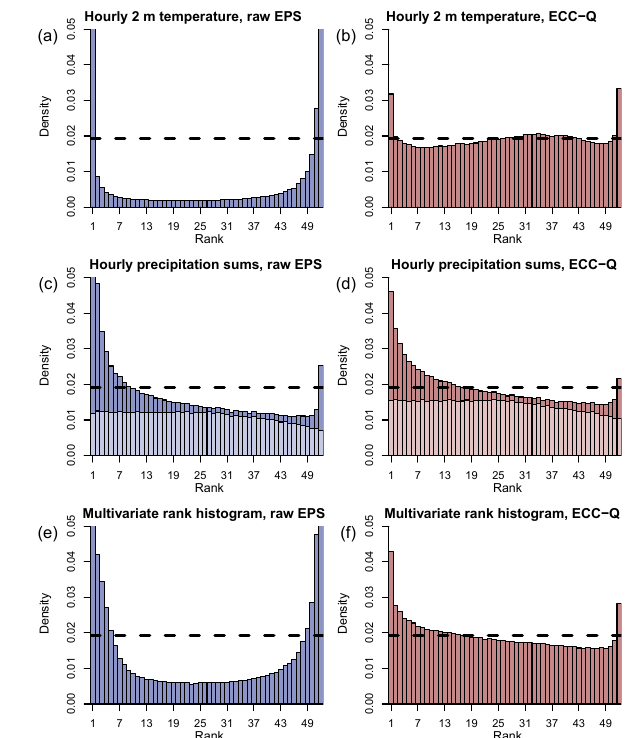
Figure 6. (Stacked) ensemble rank histograms for hourly 2m tem- perature (a, b) and hourly precipitation sum forecasts (c, d) plus multivariate rank histogram (e, f) of the raw EPS (a, c, e) and post- processed copula (b, d, f) with 50 + 1 members each. The rank his- tograms contain all available forecasts for all stations and forecast steps + 7, + 8 , ..., + 78h in advance. For precipitation, the faded colors show the rank histogram for all forecasts where 50% or more of all members predicted 0mmh − 1 . Please note that the y axis is cut at 0 . 05 for all